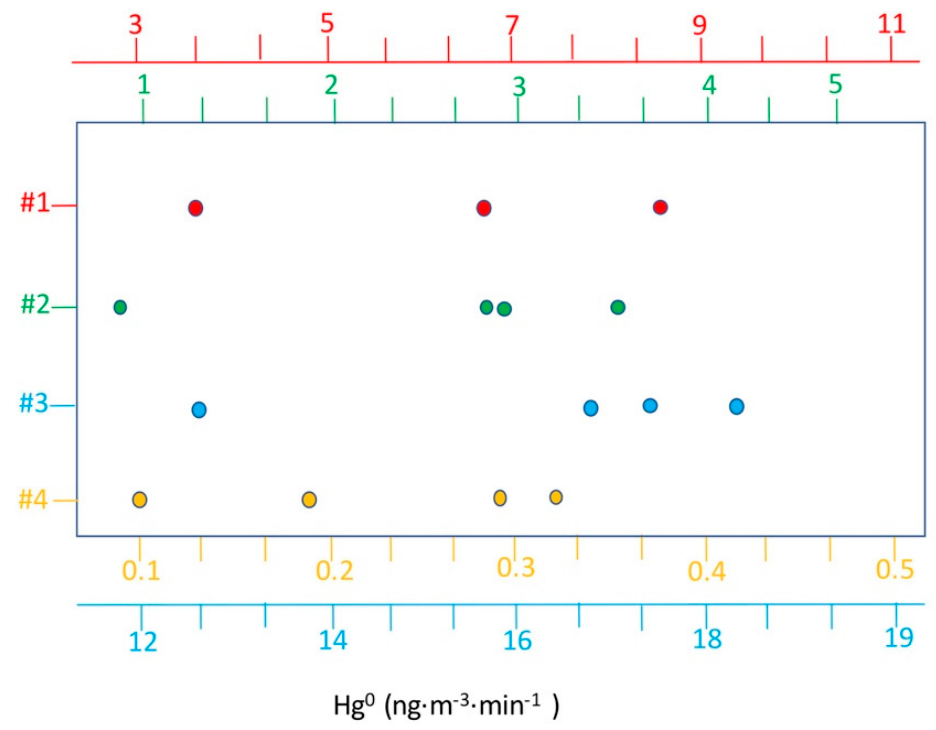
Figure 3. Rate of released Hg 0 (in ng · m 3 · min − 1 ) for the four studied samples (Table 2) for each measurement session. The colored circles refer to the studied samples as labeled in the y -axis. According to [38], indoor surfaces are adsorbing Hg 0 when subjected to mercury vapor at room − 3 temperature and 203 Hg concentration of 0.32 ± 0.04 mg · m , i.e., much higher than those